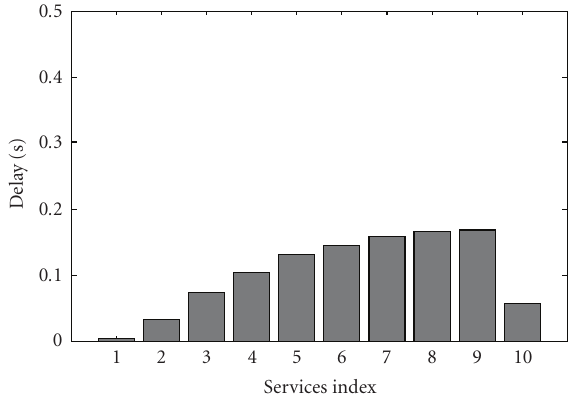
Figure 10: Bu ff ering delay in StatMux with service order compen- sation for the bit streams used in Figure 9.